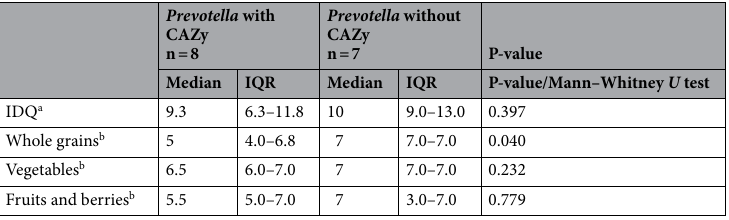
Table 2. Consumption of whole grains, vegetables, fruits and berries among donors with exceptionally high abundance of Prevotella (and Prevotella- associated CAZy profile, left) and among donors with intermediate levels (and no CAZy profile, right) of Prevotella in their microbiota (median ± interquartile range, IQR). a Index of diet quality (see text); b the number of days consumed in a